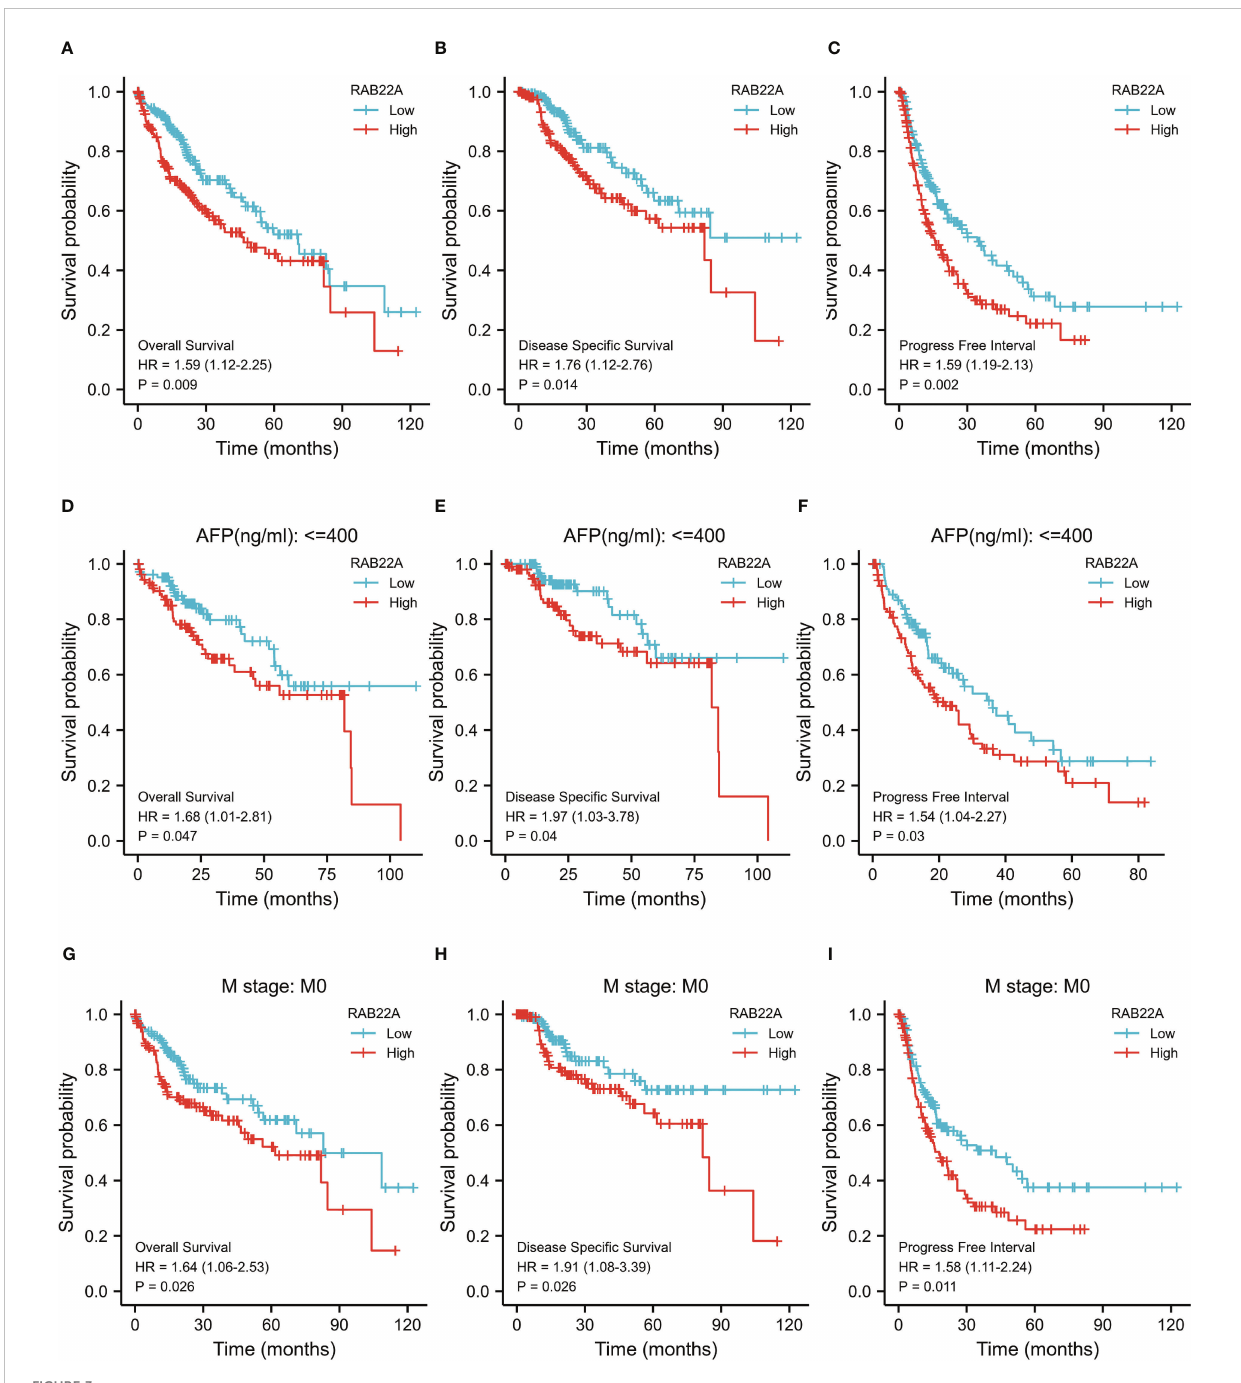
FIGURE 3 Kaplan – Meier survival plots comparing the relationship between RAB22A and prognosis in HCC. (A – C) Survival curves of OS, DSS, and PFI between RAB22A-high and -low patients with HCC. (D – F) OS, DSS, and PFI survival curves of patients with HCC with high and low RAB22A expression of AFP (ng/mL) ≤ 400. (G – I) Survival curves comparing OS, DSS, and PFI in patients with HCC at the M0 stage with high and low expression of RAB22A